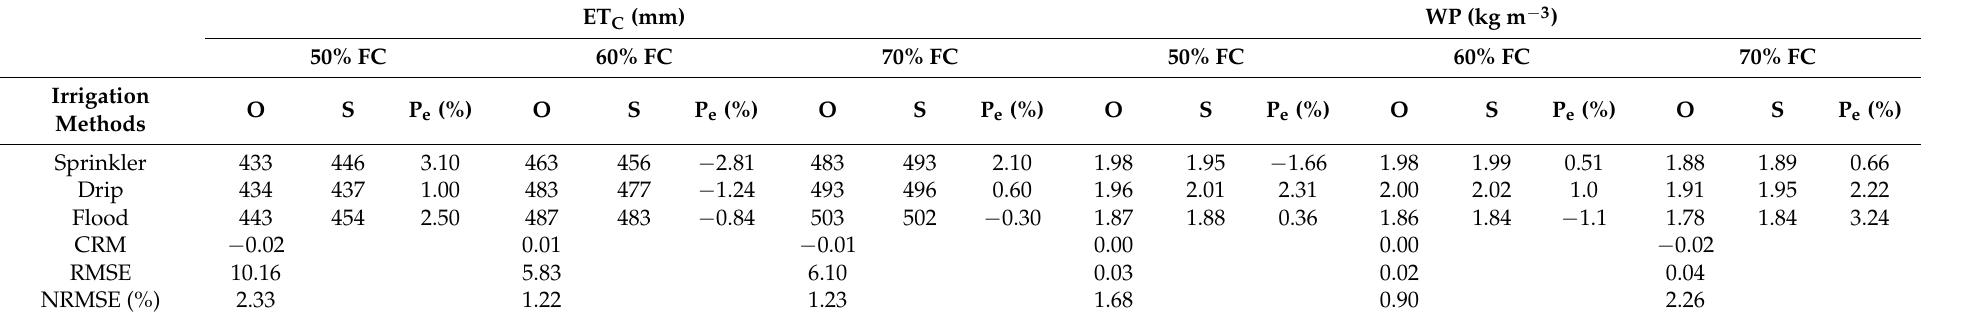
Table 8. Calibration results of crop evapotranspiration ET c and water productivity WP in